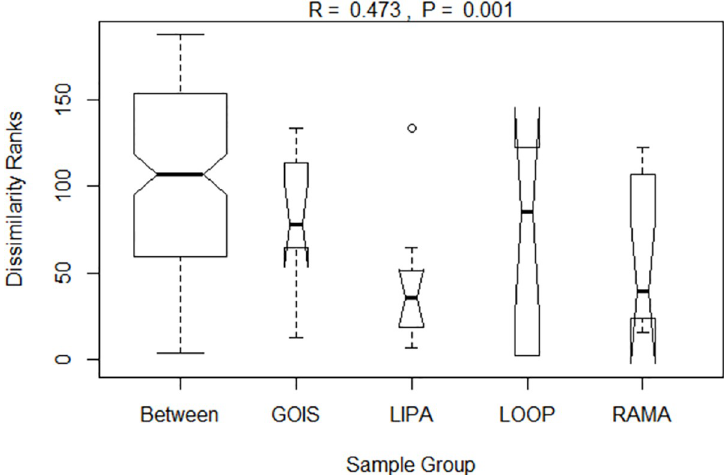
Fig 3. Analysis of similarity (ANOSIM) of aquatic bird communities to visualize within and between group dissimilarities. Dissimilarity ranks between and within river sections using Whittaker’s beta diversity. Communities are more similar within groups than between groups (p = 0.001), but there is still a lot of variability (high and low dissimilarity) within groups (R = 0.473). An R value close to 1 would suggest strong dissimilarity between groups, while an R value close to 0 would suggest an even distribution of high and low ranks of dissimilarities between and within groups.